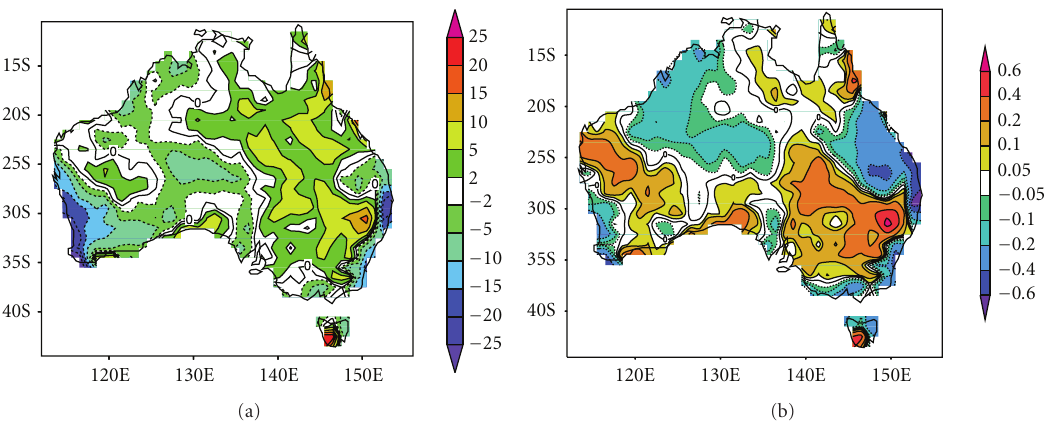
Figure 1: Observed July Australian rainfall di ff erences (1975–94) minus (1949–68) (mm/month) (a) and 1950 to 1999 trend in July Australian rainfall (mm/month/year)